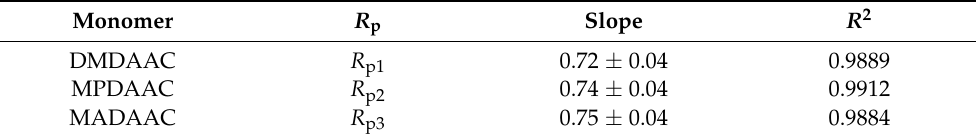
Table 4. Experimental results of fitting curve slopes of lg R p versus lg [ I ] of different monomers. Monomer R